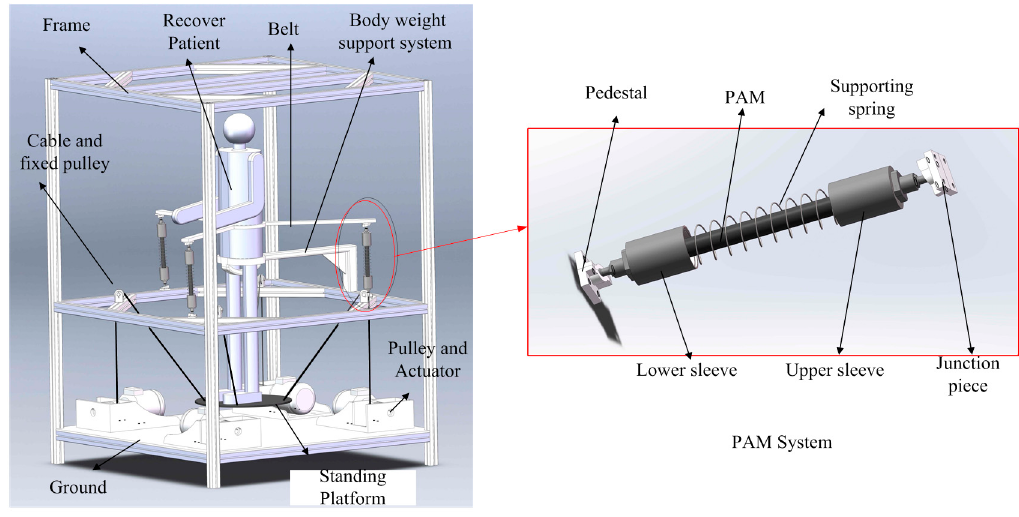
Figure 1. The structure of the HWRR.